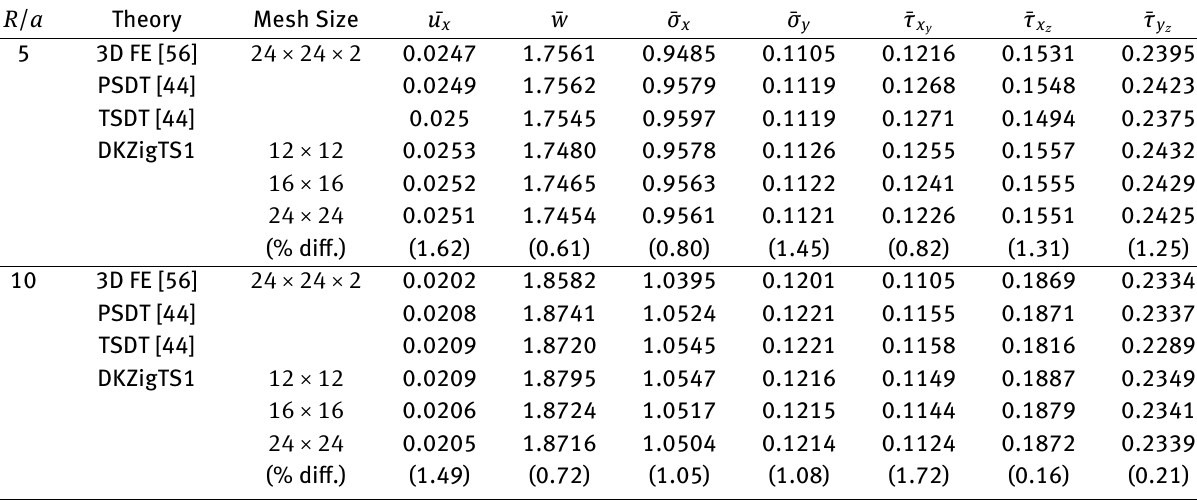
Table 14: Non-dimensionalised central deflection and stresses for an all round simply supported composite spherical shell panel ‘B’ with b / a = 1 , h / a = 0.1 under uniformly distributed load